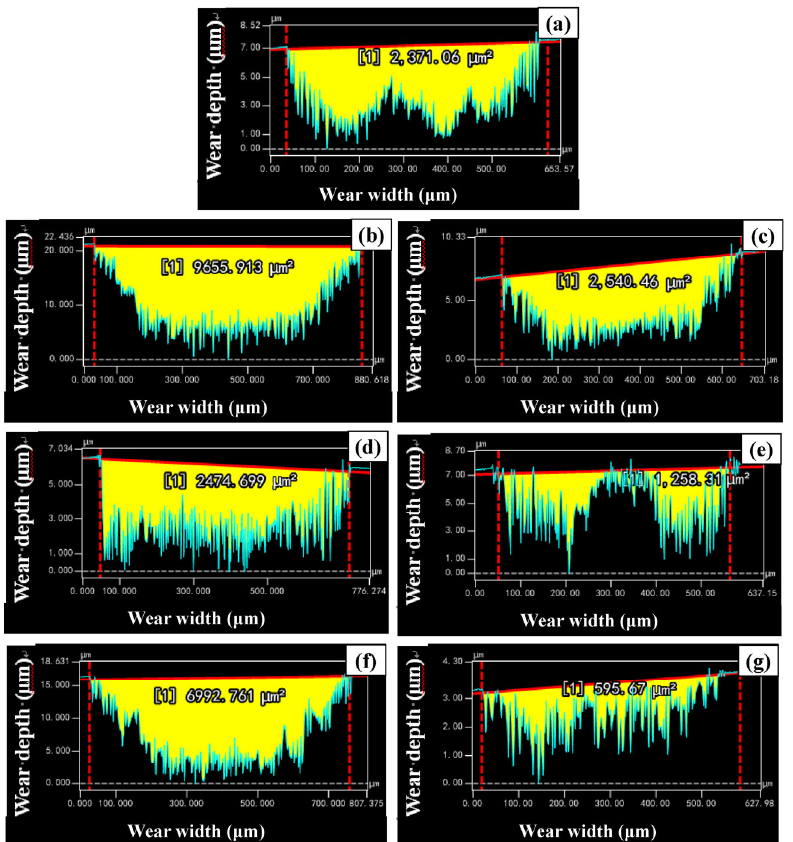
Fig. 10 Crossing areas of wear traces of disks lubricated with different oil samples at 100 N and 25 mm/s for 60 min. (a) PEG; (b) 1 wt% CQD; (c) 1 wt% Ni-CQD; (d) 2 wt% CQD; (e) 2 wt% Ni-CQD; (f) 3 wt% CQD; (g) 3 wt%